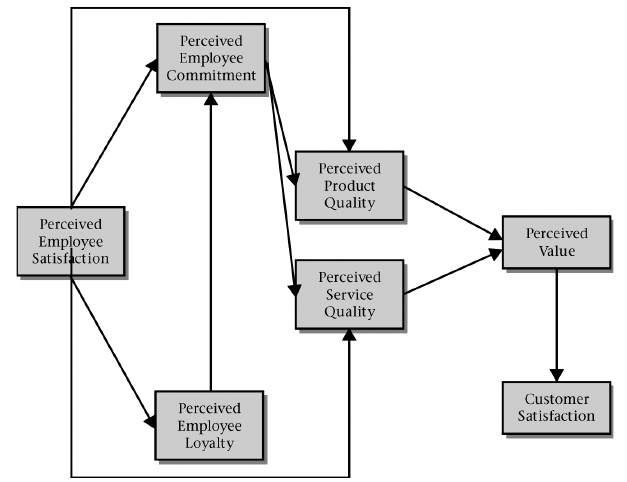
Figure Figure 1: Employee Satisfaction Model Source: Vilares & Cohelo (2000)